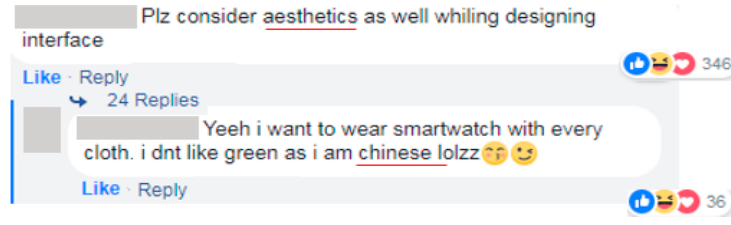
Figure 9. Gender- and Culture-sensitive requirements.